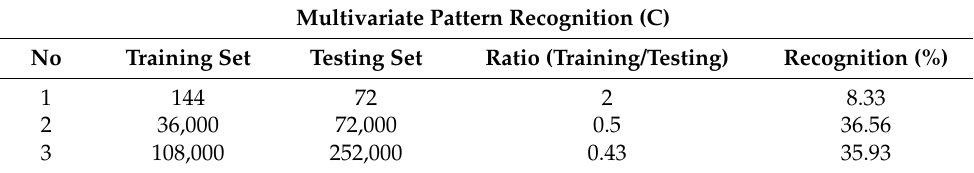
Table 4. D 2 Recognition with SVM and C